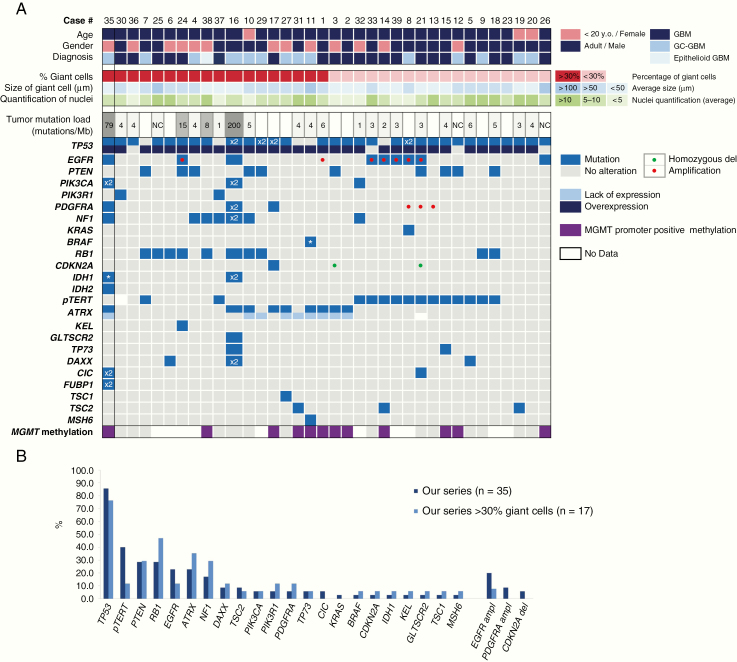
Genetic findings. (A) Summary of clinical, histopathological, and molecular findings. No genetic alterations were found in H3F3A, HIST1H3B, CDKN2B, LZTR1, MET, FOXR2, and QKI. ×2, two mutations; *hotspot; del, deletion; NC, non contributive. (B) Frequencies of glioma gene alterations in the whole series (dark blue) and in those cases with more than 30% of multinucleated giant cells (light blue).